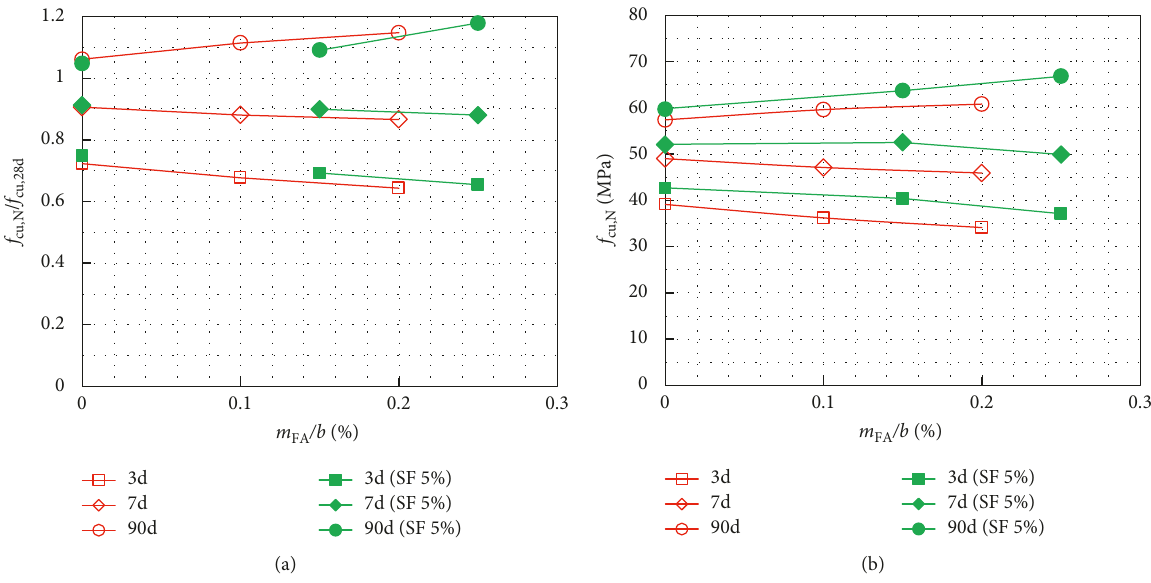
Figure 9: Effect of (m) FA /(b) on (f) cu,N /(f) cu,28d . (a) f cu,N /f cu, 28d versus mFA/b [13] and (b) f cu,N versus m FA / b